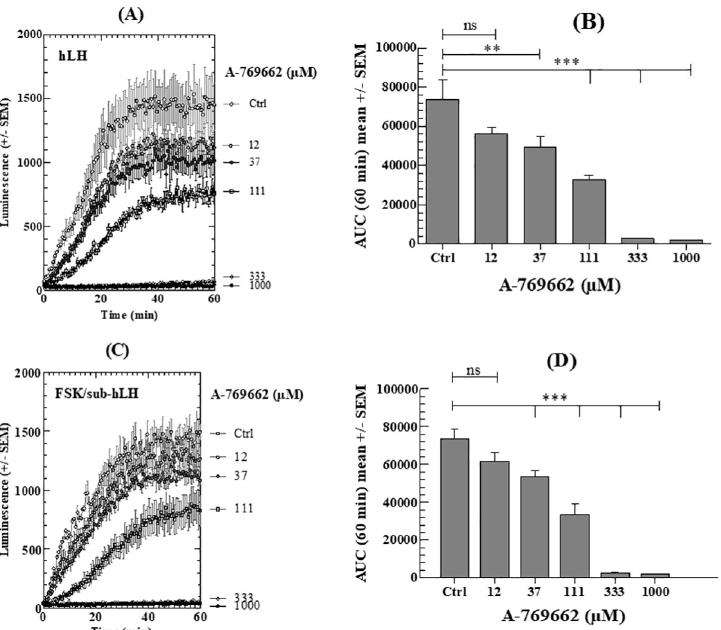
Fig 4. Effect of A-769662 on intracellular cAMP response of MLTC-1 cells to hLH or FSK/sub-hLH. (A), (C) Real- time recording of luminescence under stimulation of MLTC-1 cells by hLH and FSK/sub-hLH respectively in presence of 0 to 1000 μ M A-769662. (B), (D) Dose-dependent effects of A-769662 on hLH and FSK/sub-hLH responses respectively, determined by the Area Under Curve (AUC) of individual kinetics in Fig 4A and 4C. Data represent mean ± SEM of 3 independent experiments (n = 3). Results were analyzed by one-way ANOVA, followed by the Dunnett’s test posttest). � : significant difference ( �� p < 0.01; ��� p < 0.001), ns: no significant